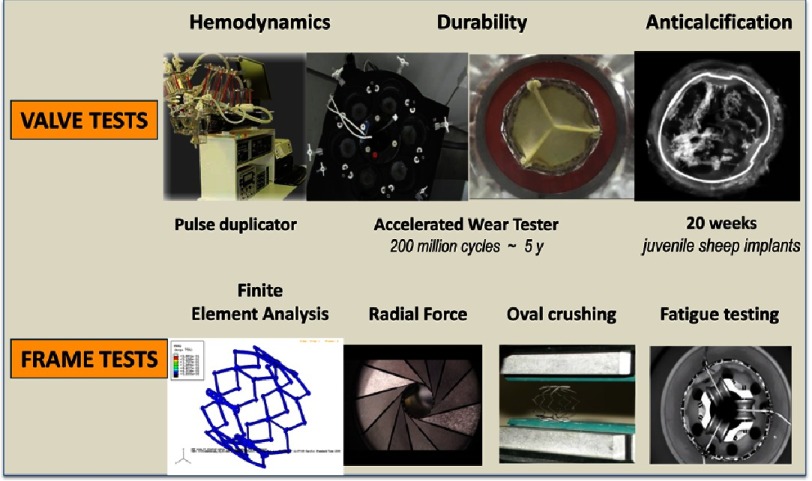
New testing equipment designed by PVT for the evaluation of valve structure and frame.